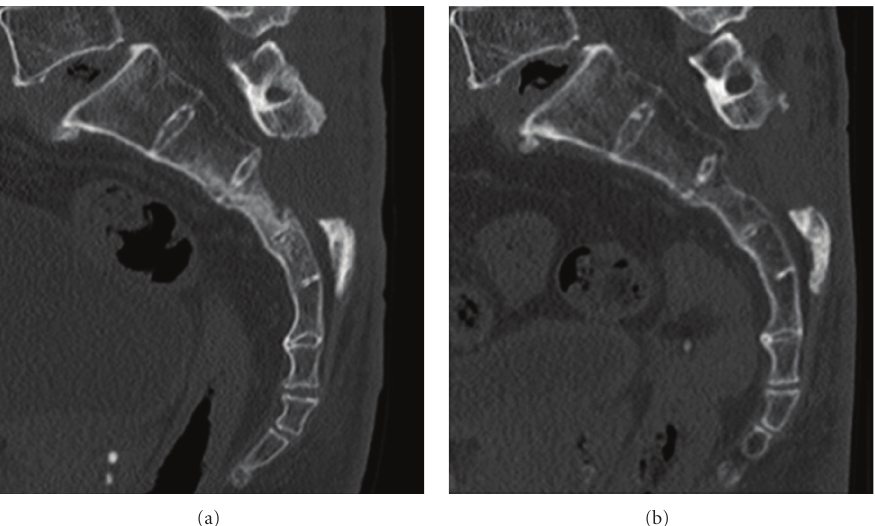
Figure 5: Postoperative follow-up reconstructed CT. (a) Two months after surgery, the third sacral vertebral body showed a high-density